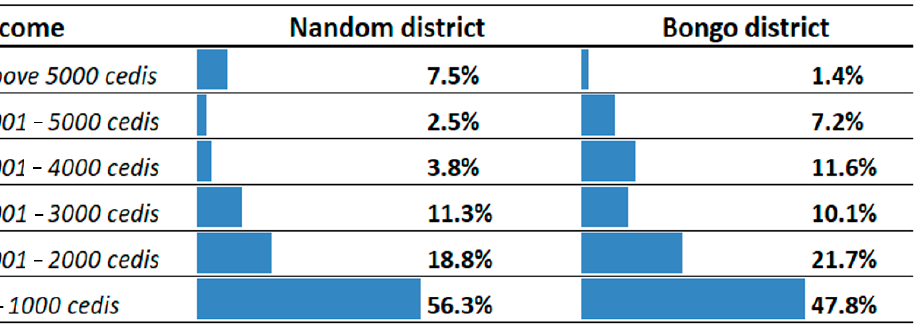
Figure 6. Average annual income from farming in the districts.